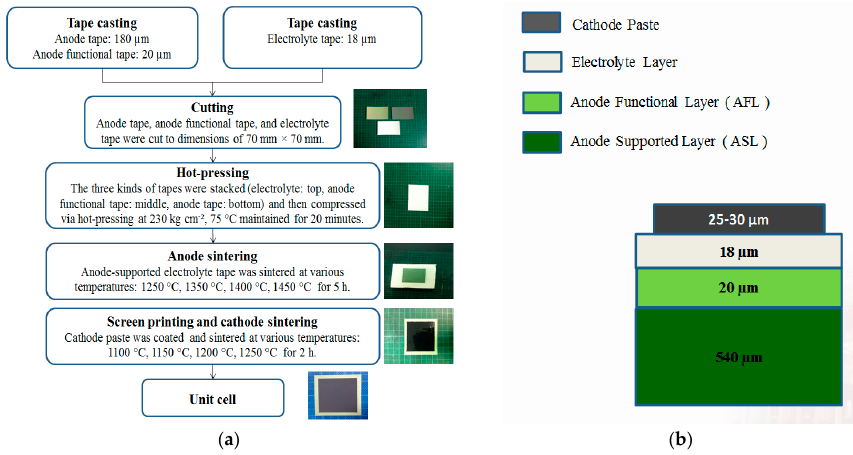
Figure 1. ( a ) Flowchart of the manufacturing process for the SOFC cell; and ( b ) structure of the anode ‐ supported cell SOFC. anode-supported cell